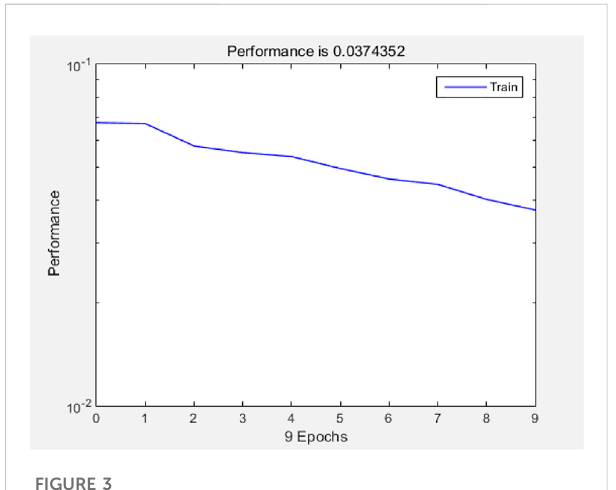
FIGURE 3 Training error curve of RBF neural network.